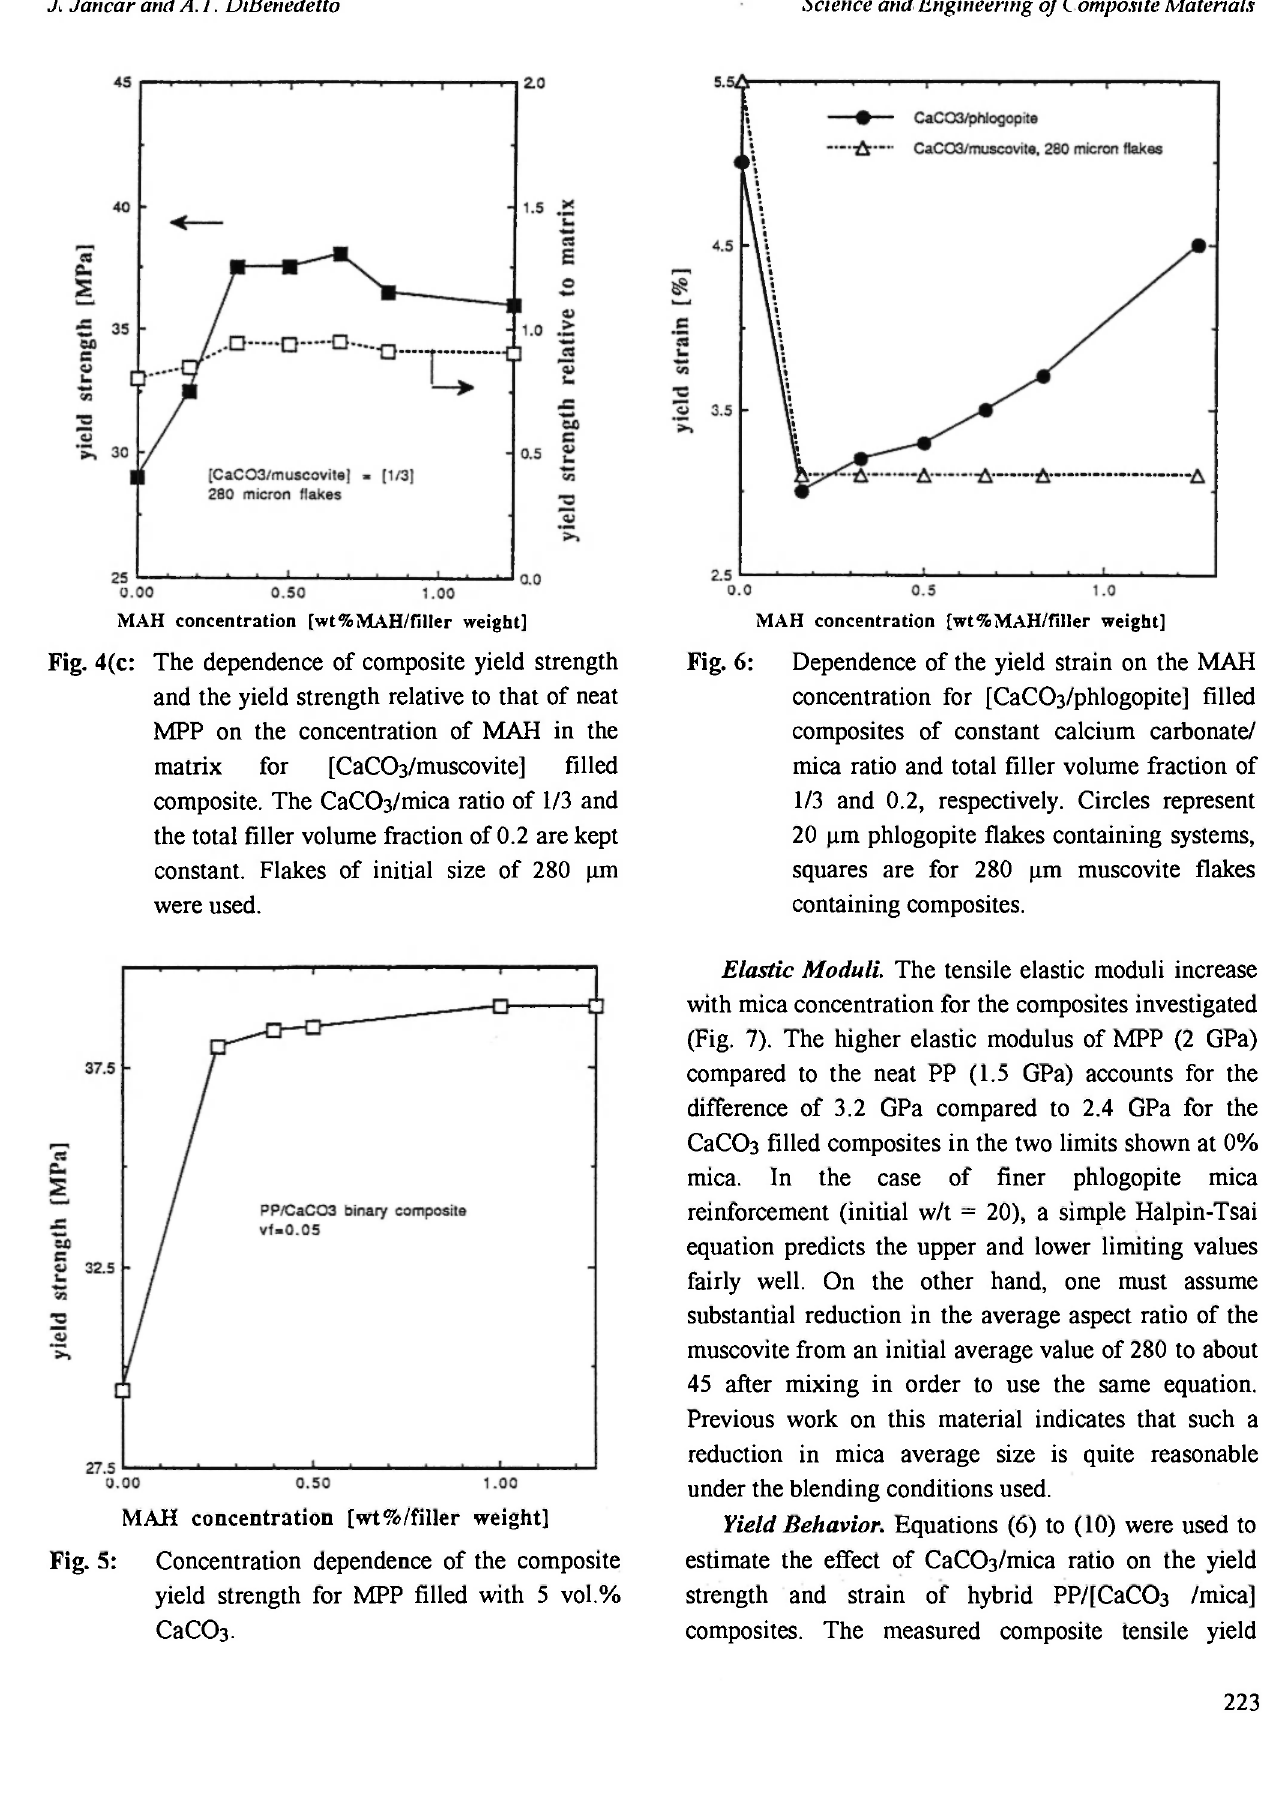
Fig. 4(c: The dependence of composite yield strength and the yield strength relative to that of neat MPP on the concentration of Μ ΑΗ in the matrix for [CaC03/muscovite] filled composite. The CaCC >3 /mica ratio of 1/3 and the total filler volume fraction of 0.2 are kept constant. Flakes of initial size of 280 μπι were used.